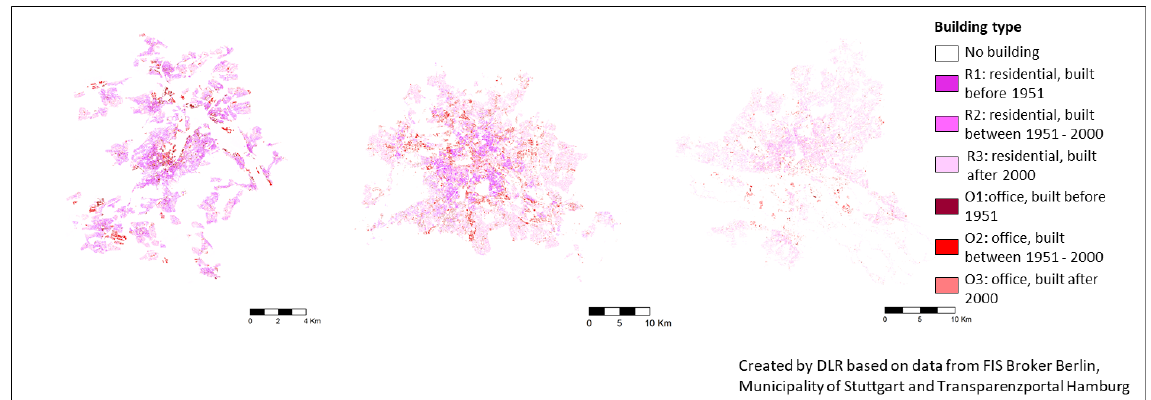
Figure 4. Building type maps of Stuttgart, Berlin and Hamburg (from left to right). Sources: FIS Broker (dl-de/by-2-0: https://www.govdata. de/dl-de/by-2-0, last access: 26 October 2020) ATKIS, Municipality of Stuttgart and Freie und Hansestadt Hamburg, Landesbetrieb Geoin- formation und